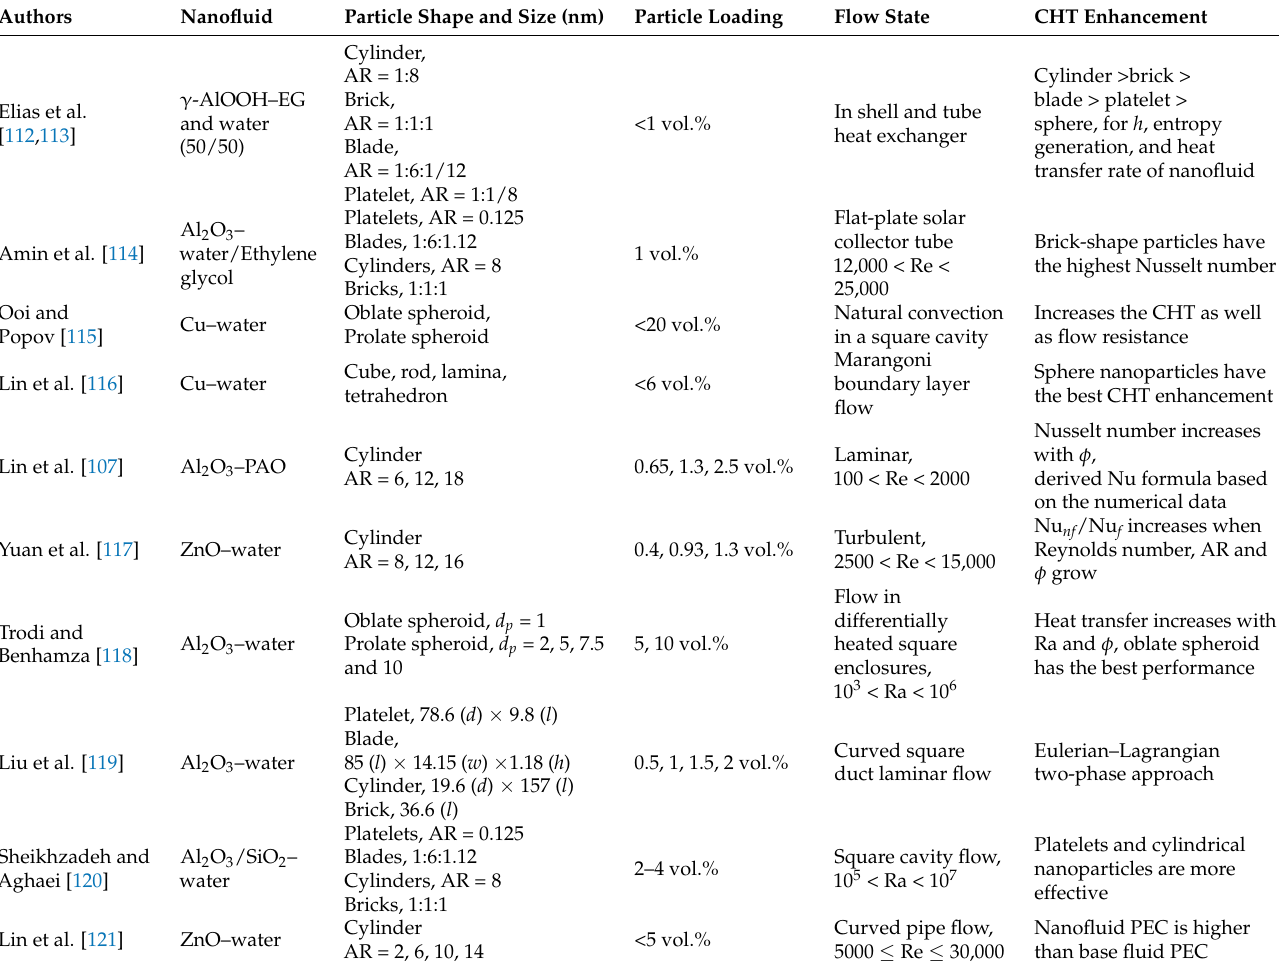
Table 4. Typical numerical studies for CHT of NSN